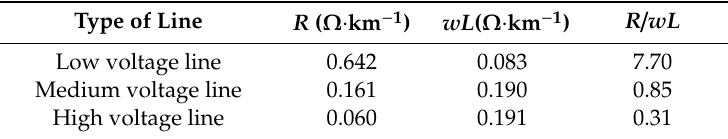
Table 1. Typical line